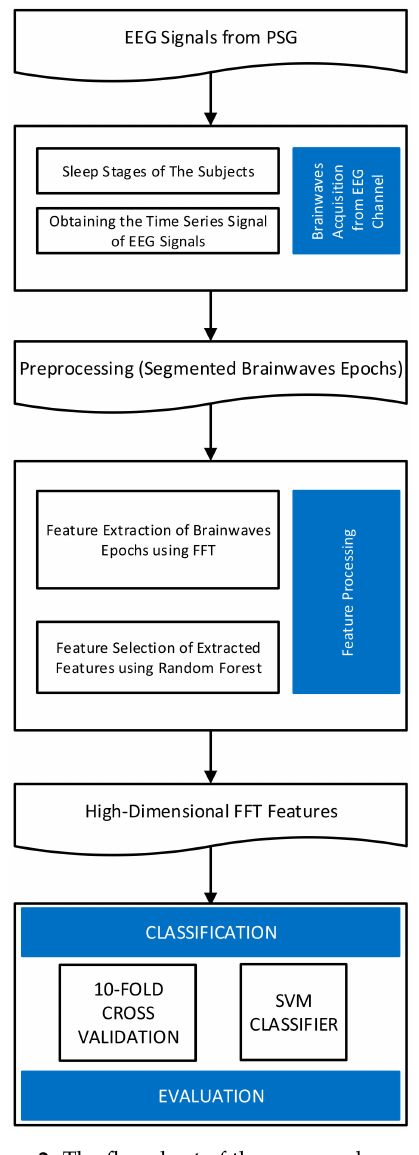
Figure 2. The flowchart of the proposed